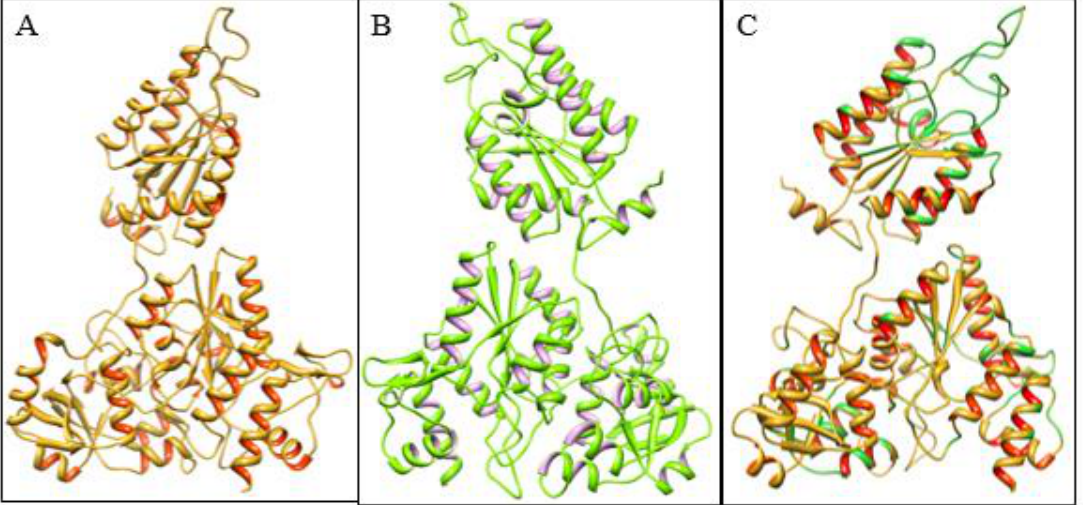
Figure 4. Predicted protein structures for PAPSS2. ( A ) Predicted protein structure for wild PAPSS2. ( B ) Predicted protein structure for mutant PAPSS2. ( C ) Superimposition of wild (orange and red) and mutant (green) structures (PAPSS2).